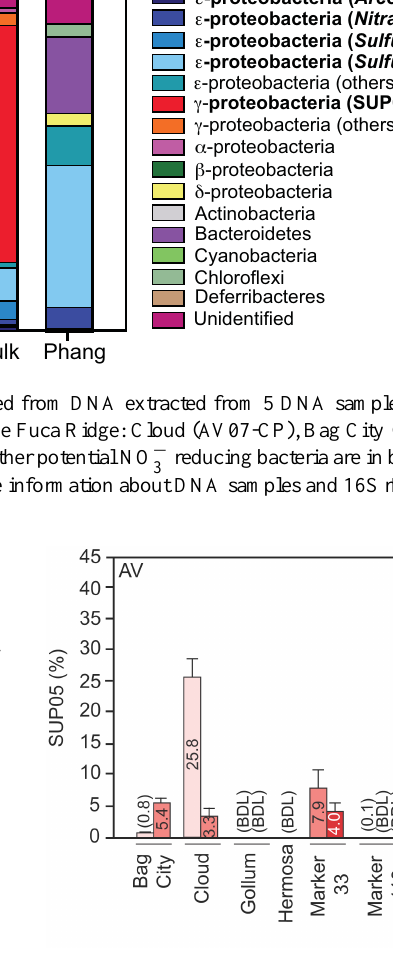
Fig. 5. SUP05 relative abundance (in %, relative to 16S rRNA gene copy numberml − 1 seawater) at Axial Vocano (AV) and the Endeavour Segment (ES) on the Juan de Fuca Ridge. Same colour scheme as in Fig. 3 (paler colours represent samples from the 2007 cruise). Actual values are indicated inside the bars or within parentheses. Bkgd is a background sample that was collected near the Endeavour Segment in 2009. See Table 1 for chemico-physical properties of sampled sites. Copy numbers per ml seawater of bacterial 16S rRNA genes (for both total and SUP05 bacteria) are available as Supplement Materials, Table